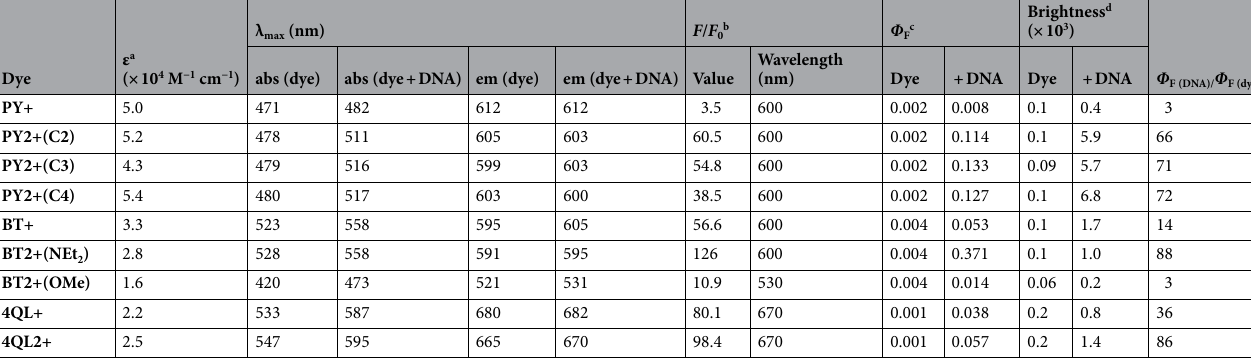
Table 1. Optical properties of cationic styryl dyes in the absence and presence of dsDNA: absorption maxima λ max (abs), extinction coefficients (ε), emission maxima λ max (em), fluorescence quantum yield ( Φ F ) and fluorescence enhancement ratio ( F / F 0 ). Conditions: [Dye] = 2 μM, [DNA] = 1 μM; [DNA(in bp)] : [Dye] = 15 : 1; all measurements were performed in 10 mM sodium phosphate buffer pH 7.0. dsDNA = 5 ′ -CGC GGC GTA CAG TGA TCT ACC ATG CCC TGG -3 ′ + 3 ′ -GCG CCG CAT GTC ACT AGA TGG TAC GGG ACC -5 ′ . a In MeOH ([Dye] = 0–10 μM). b Fluorescence intensity with dsDNA ( F ) and without dsDNA ( F 0 ). c The following reference dyes were used: Rhodamine 6G ( Φ F = 0.95, λ ex = 470–510 nm) for PY series, BT+ and BT2+ (NEt 2 ) ; Fluorescein ( Φ F = 0.95, λ ex = 470–490 nm) for BT2+(OMe) ; cresyl violet ( Φ F = 0.54, λ ex = 540–590 nm) for 4QL+ and 4QL2+. d Brightness = ε × Φ F